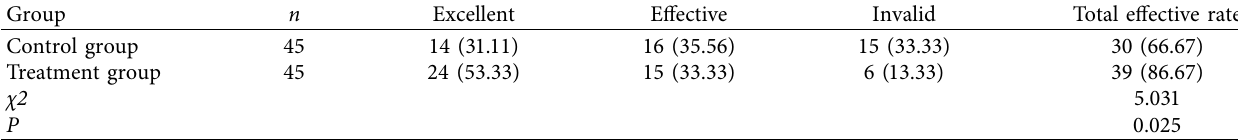
Table 2: Comparison of effect on cardiac function between two groups (n (%)).